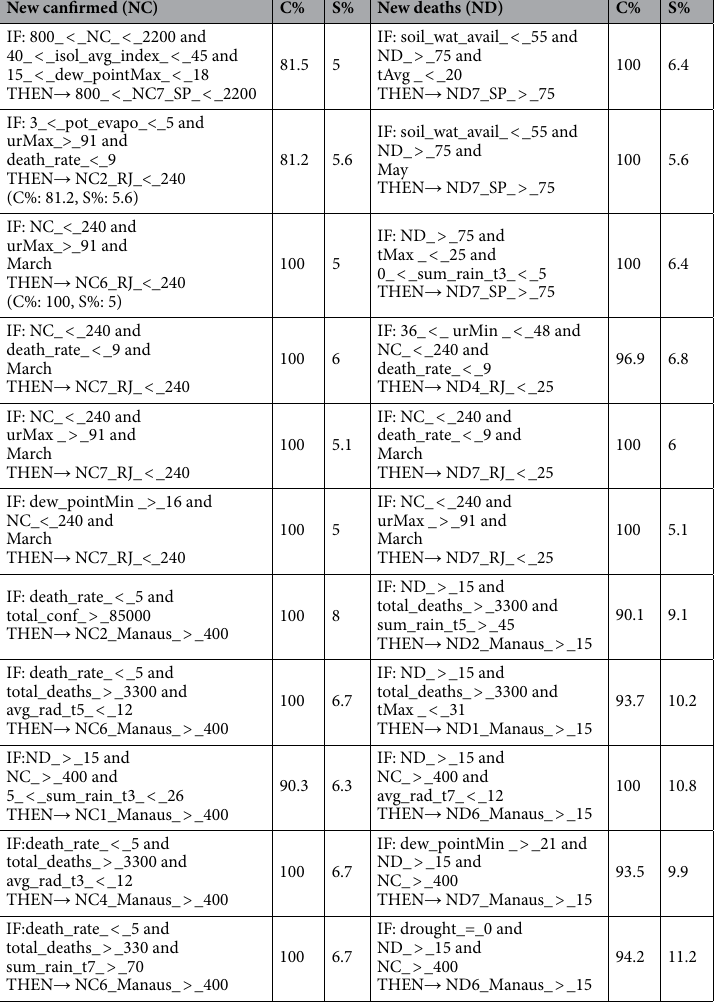
Table 1. Predictive models generated by the